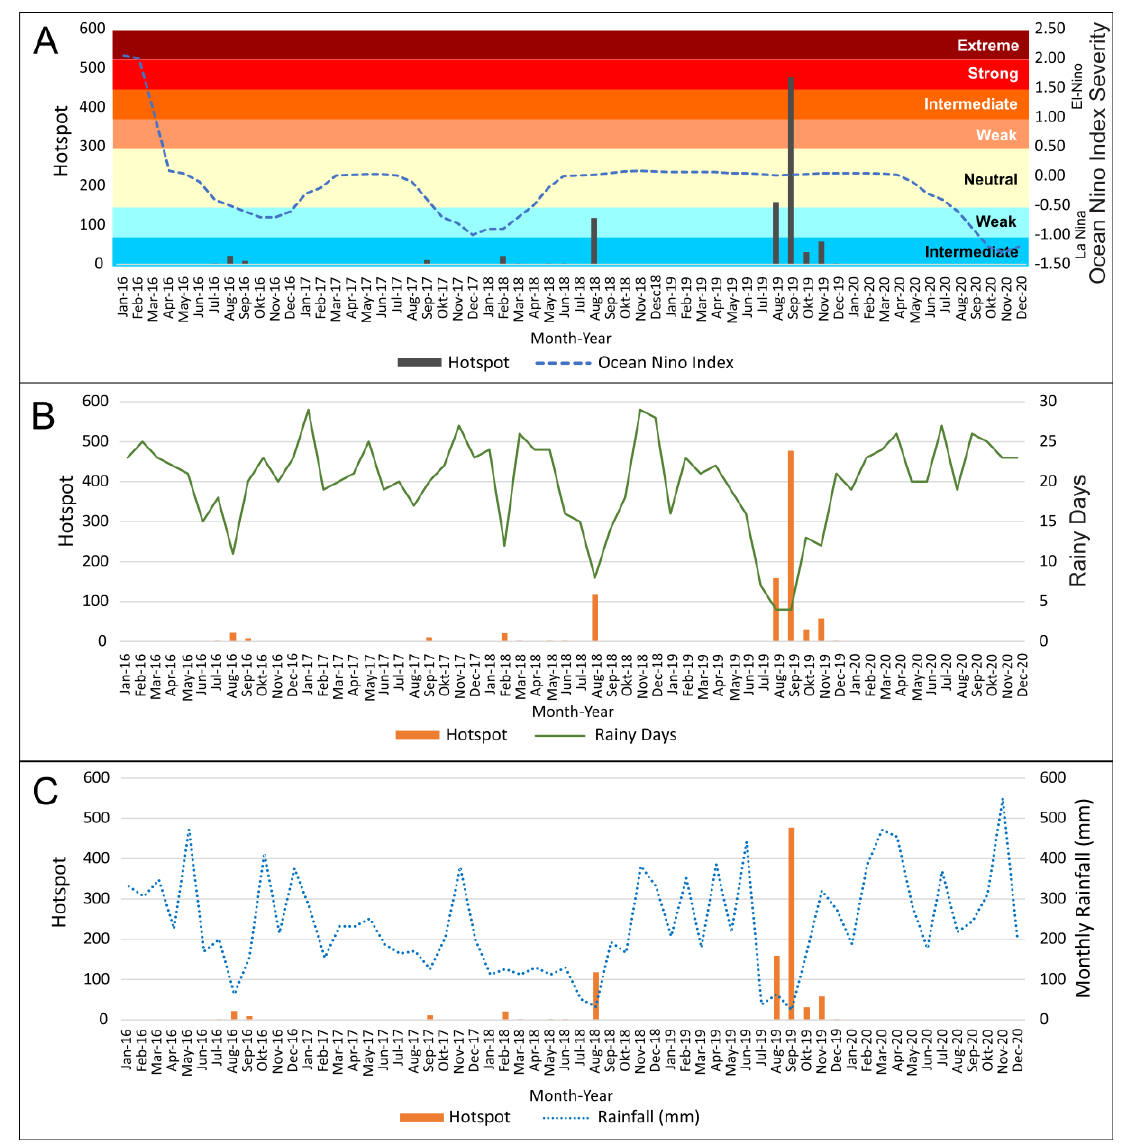
Figure 4. Inter−annual hotspot variability ( A ) correlation of hotspots with ocean nino index, ( B ) correlation of hotspots with rainy days, ( C ) correlation of hotspots with monthly rainfall (mm).